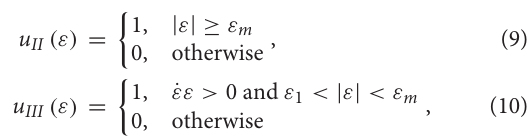
FIGURE 3 | Superelasticity ( f T > 0) with the Graesser-Cozzarelli model, (A) base model with E 0.001 (B) variation in f T (C) variation in and ¯a only (c =